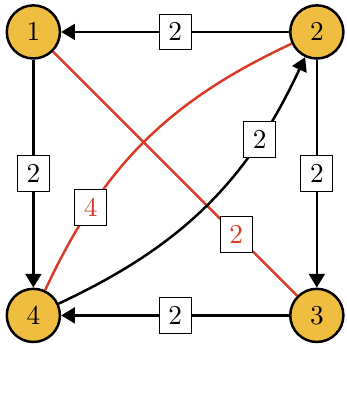
Figure 13 . Toric diagram for Q 1 , 1 , 1 .